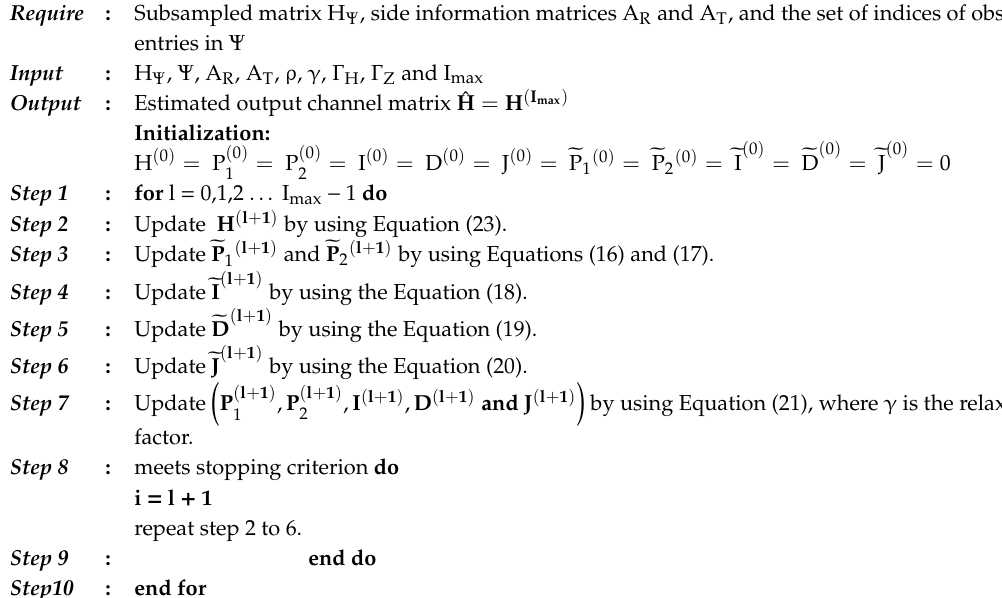
Algorithm 1. Ex-ADMM based mmWave MIMO Channel Estimation